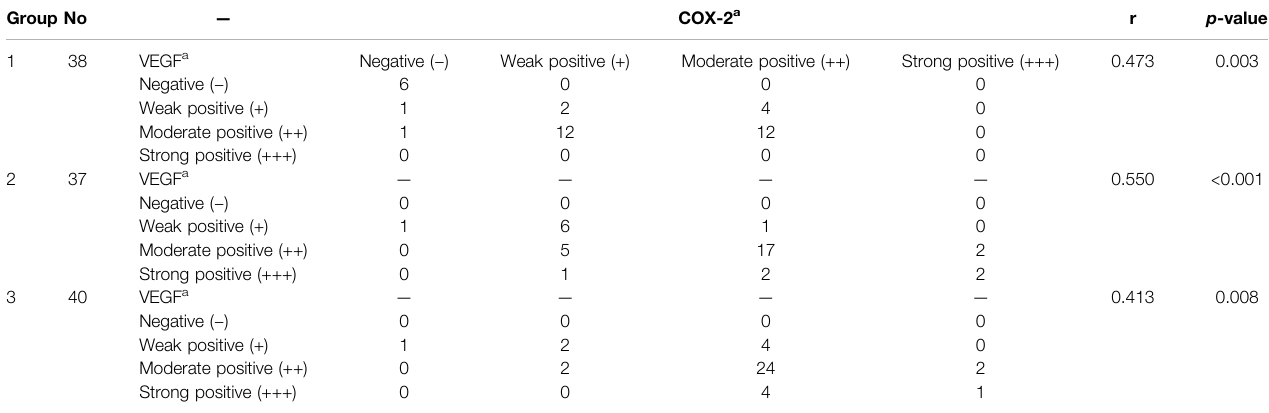
TABLE 3 | Correlations between levels of VEGF and COX-2 expression in primary pterygium patients. Group